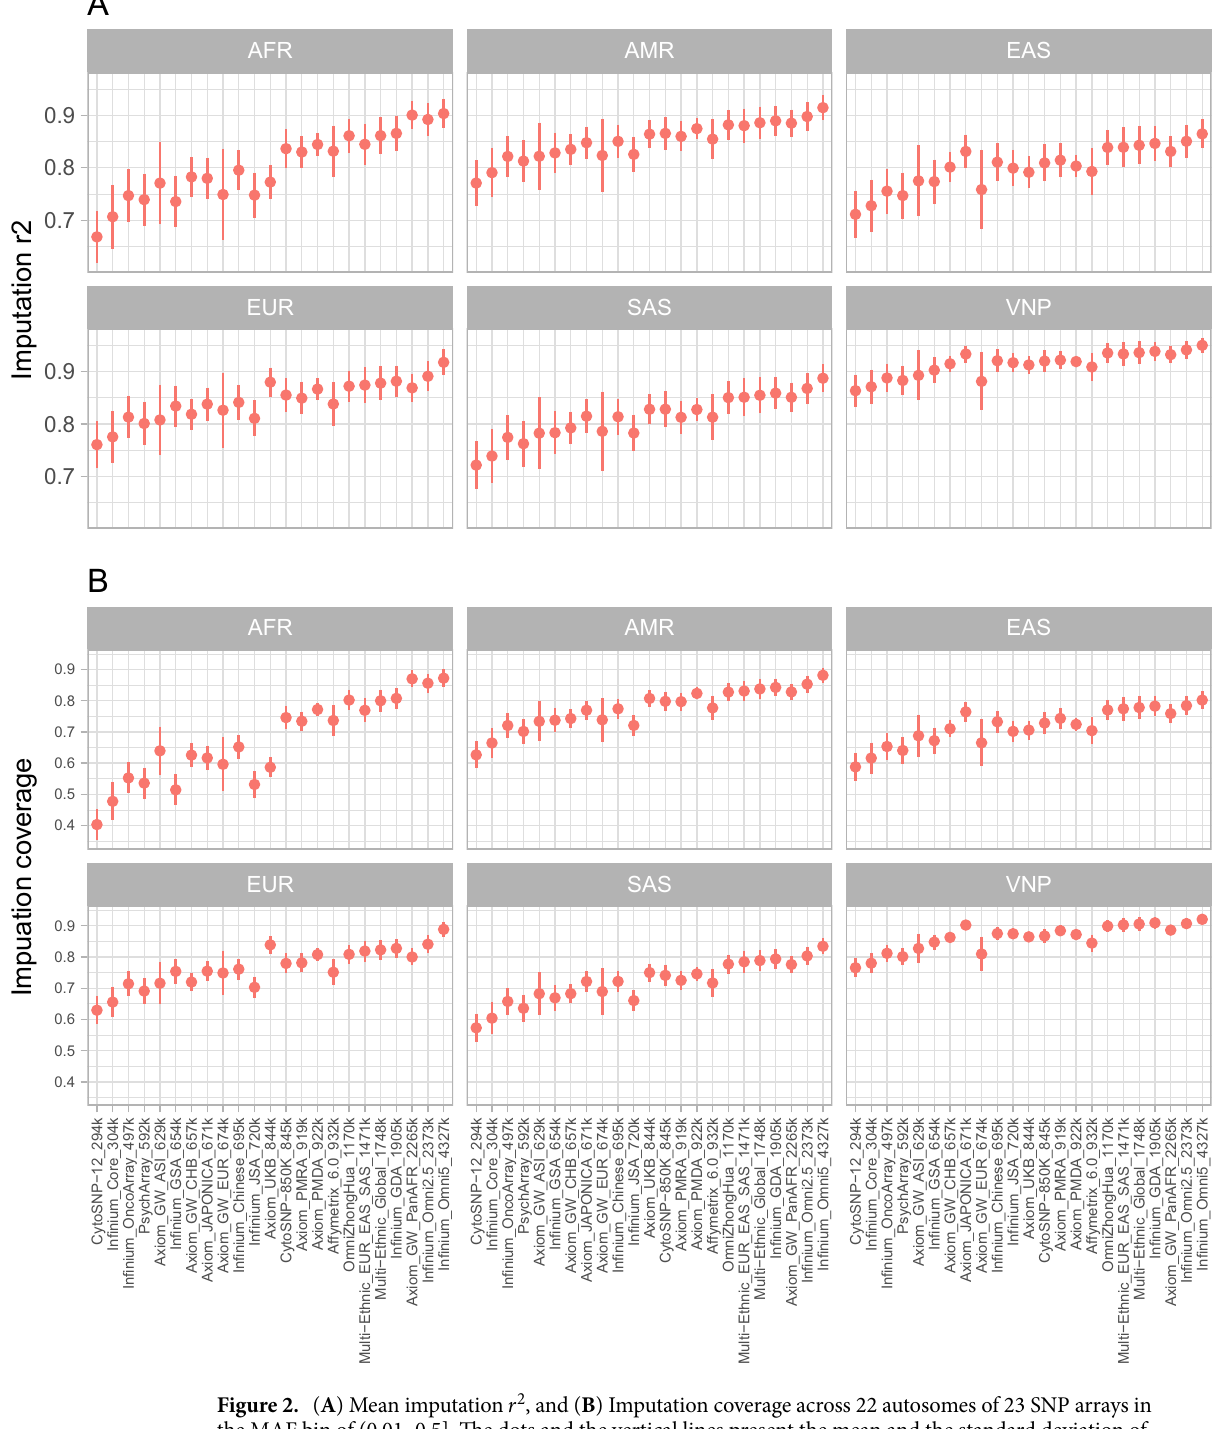
Figure 2. ( A ) Mean imputation r 2 , and ( B ) Imputation coverage across 22 autosomes of 23 SNP arrays in the MAF bin of (0.01–0.5]. The dots and the vertical lines present the mean and the standard deviation of imputation accuracy, and imputation coverage values in 22 autosomes